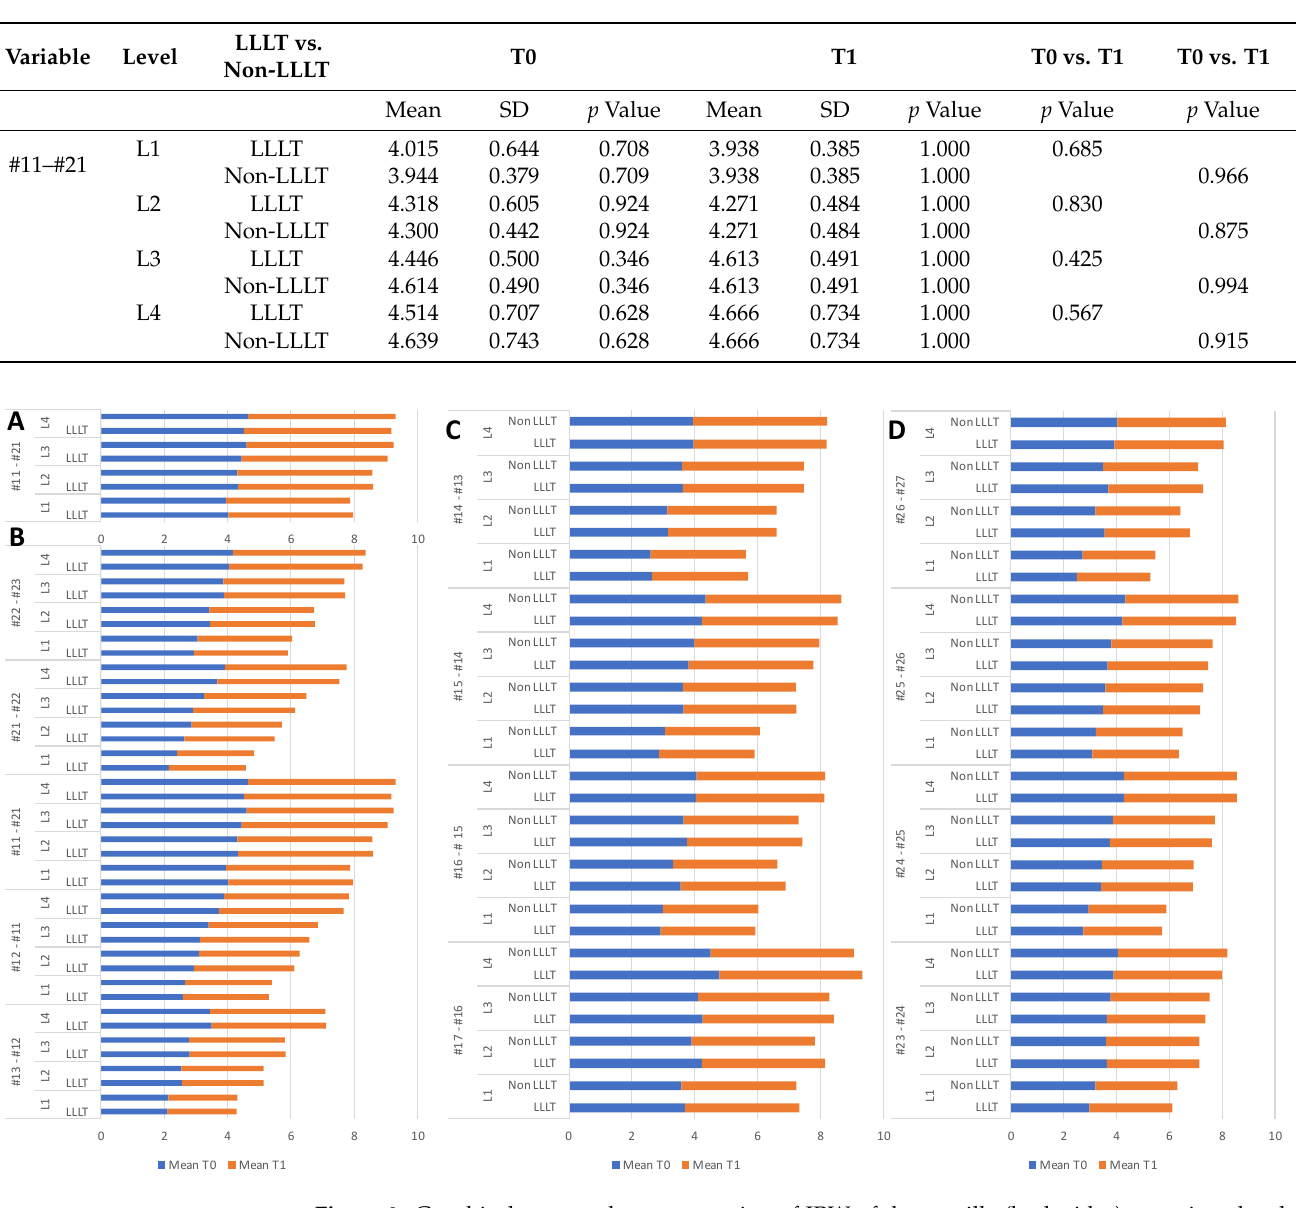
Figure 3. Graphical mean value presentation of IRW of the maxilla (both sides) at various levels. LLLT and non-LLLT differences among pre- and post-treatment of all groups: ( A ) middle quadrant, ( B ) anterior quadrant, ( C ) posterior right quadrant, and ( D ) posterior left quadrant teeth. Anterior quadrant, LLLT and non-LLLT differences: The IRW of the T0, T1, and T0 vs. T1 CBCT of 2 TM (laser vs. non-laser) at the different levels are displayed in Table 2 and Figure 3B. At T0, T1, and T0 vs. T1 CBCT, the data of all four levels are insignificant. In general, most of the data showed improvement in T1 compared to T0. Table 2. IRW of the maxilla (both sides) at various levels. LLLT and non-LLLT differences among pre- and post-treatment groups—anterior quadrant teeth.